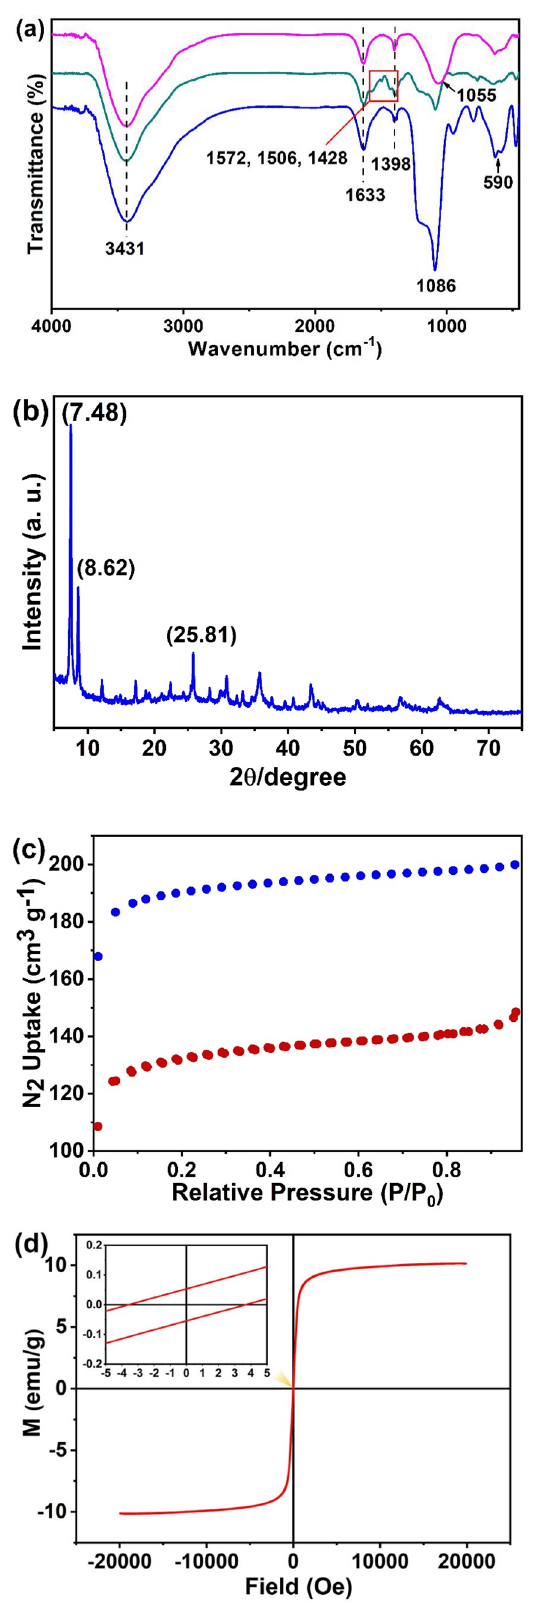
Figure 3. ( a ) FT-IR spectra of Fe 3 O 4 @SiO 2 (blue line), Fe 3 O 4 @SiO 2 @UiO-66 (green line) and Fe 3 O 4 @SiO 2 @ UiO-66-TPP (pink line) NPs. ( b ) XRD pattern of Fe 3 O 4 @SiO 2 @UiO-66-TPP NPs. ( c ) N 2 adsorption/desorption isotherms of Fe 3 O 4 @SiO 2 @UiO-66-NH 2 and Fe 3 O 4 @SiO 2 @UiO-66-TPP NPs. ( d ) Magnetization curve of